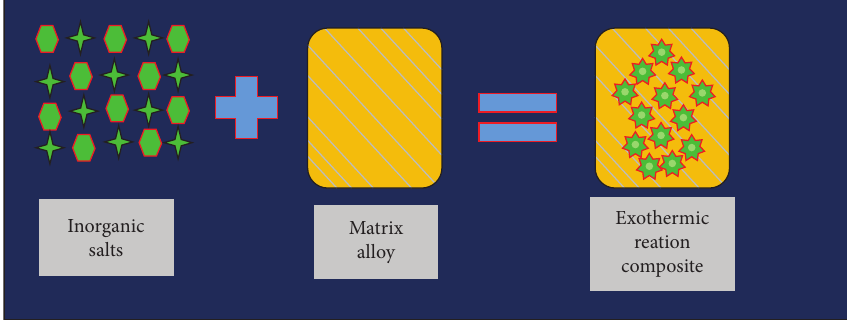
Figure 11: Manufacturing of in situ composite employing inorganic salts and aluminum matrix alloy.